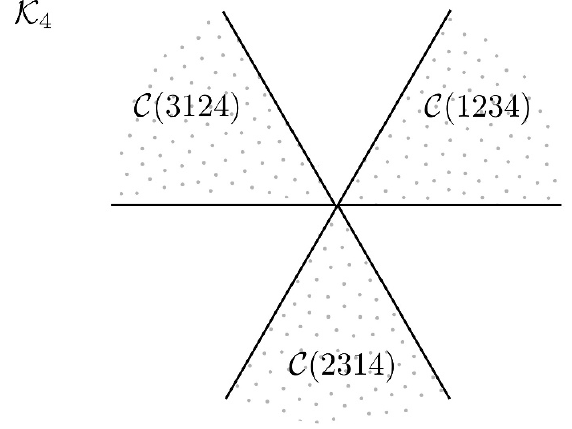
Figure 3 . The three cones C ( (cid:11) ) in the kinematic space K 4 for four points. the inverse KLT kernel | that is, m ( (cid:11) j (cid:11) ) | are also related to the fan in dual kinematic (cid:11) 0 space which encodes the partial amplitudes m ( (cid:11) j (cid:12) ). To obtain the components m